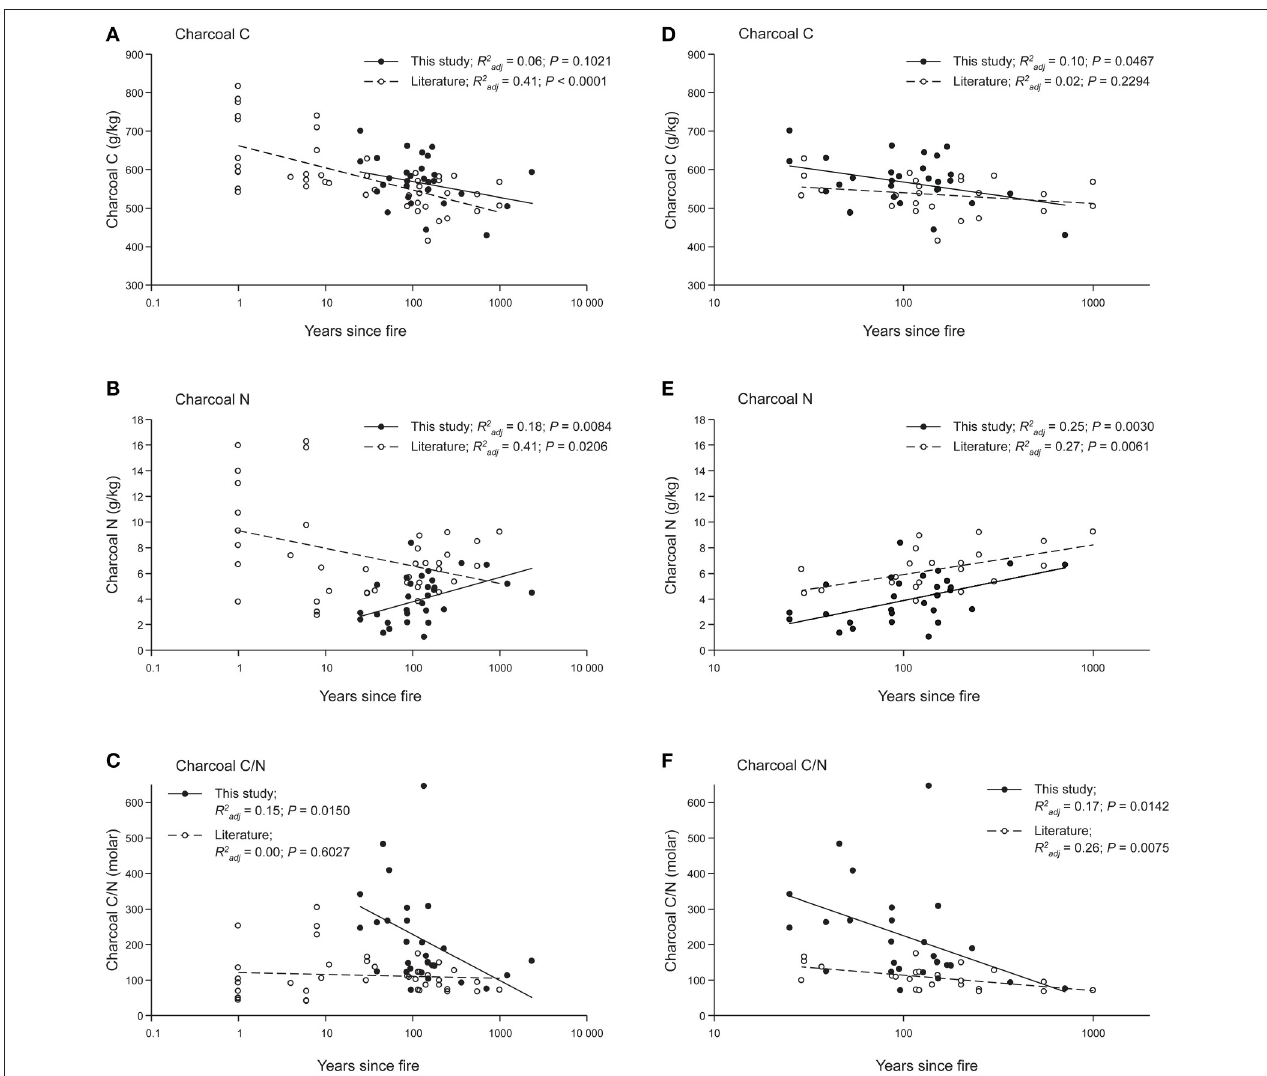
FIGURE 3 | Trends in charcoal C, N, and C/N ratio (molar) with ysf for this study (solid symbols) and for field data taken from the literature (open symbols). Linear regression on log-transformed ysf + 1 is shown for all data (A–C) and for the time period (20–1,000 ysf) common to both datasets (D–F) . Data from Schiffman